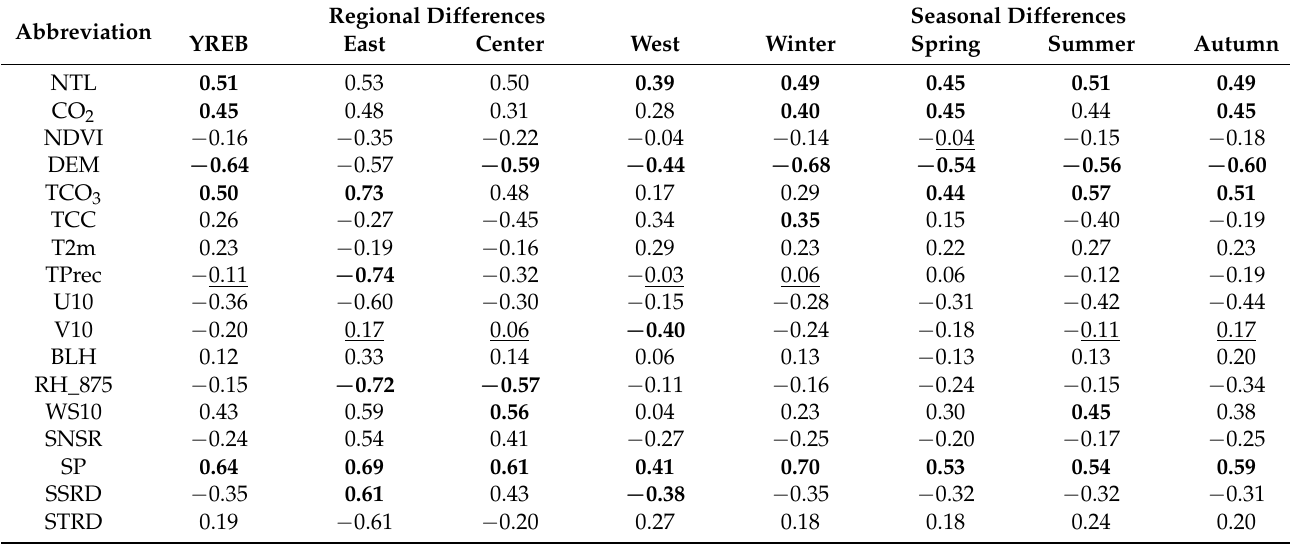
Table 1. Regional and seasonal differences in the potential impact factors’ q value of the NO 2 VCD in the YREB in